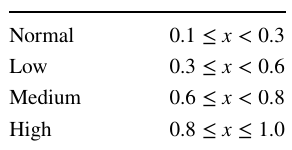
Linguistic value Value